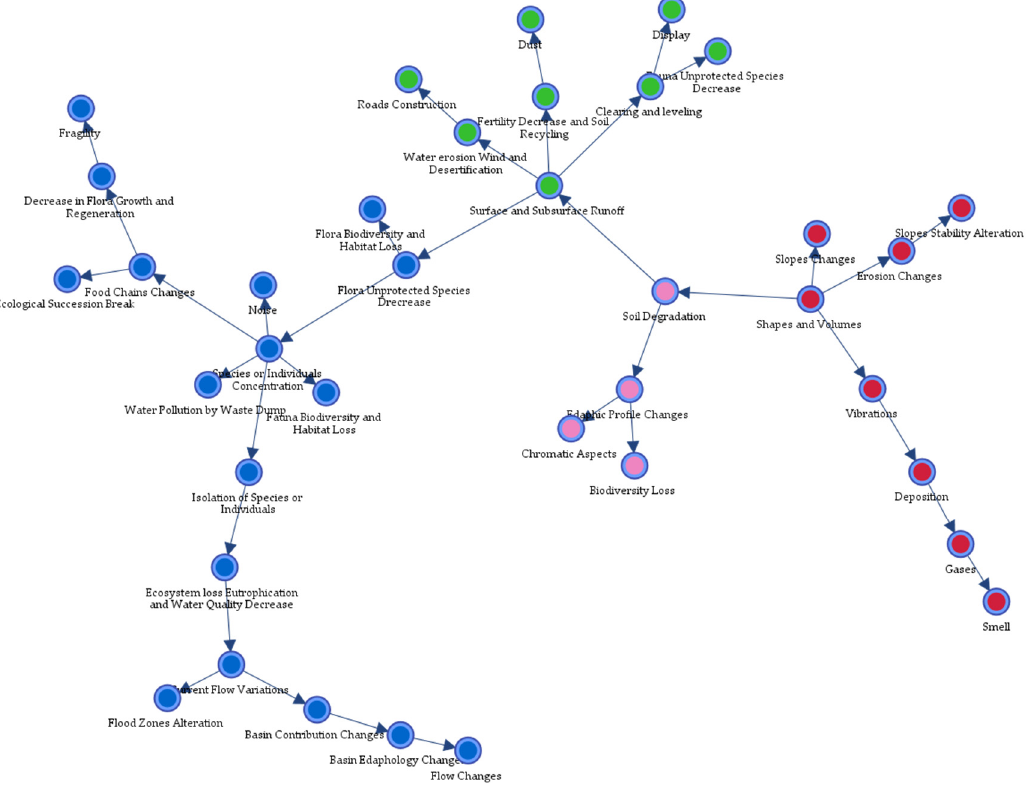
Figure 3. Unsupervised Bayesian network built with the EQ algorithm divided into mathematics clusters. The color of the nodes outlines a statistical network clustering (model-based).